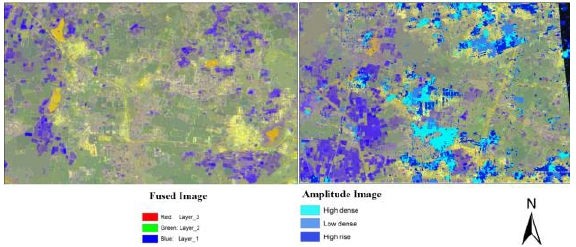
Figure 28 . Fused and Amplitude Image feature